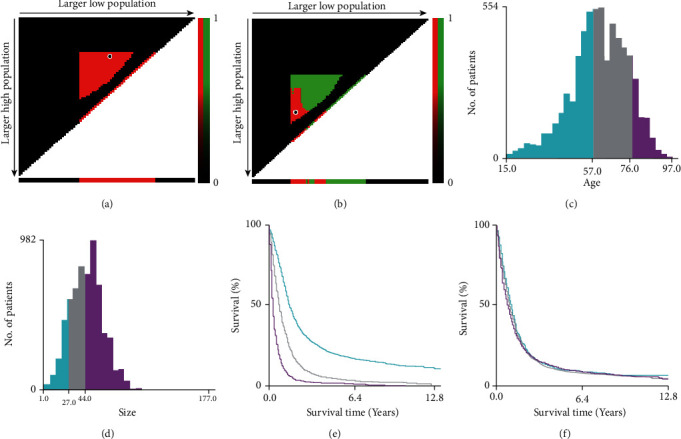
The results of the X-tile program for optimal cutoff points of age and tumor size. X-tile plot of all patients is displayed in the figure, the age optimal cutoff value marked by the black circle in the (a) is shown by a histogram of the entire cohort (c), and a Kaplan–Meier plot (e); the size optimal cutoff value marked by the black circle in the (b) is shown by a histogram of the entire cohort (d), and a Kaplan–Meier plot (f). The figure shows the optimal cutoff points for adult patients with gliomas (56 and 75; 27 and 44 mm).